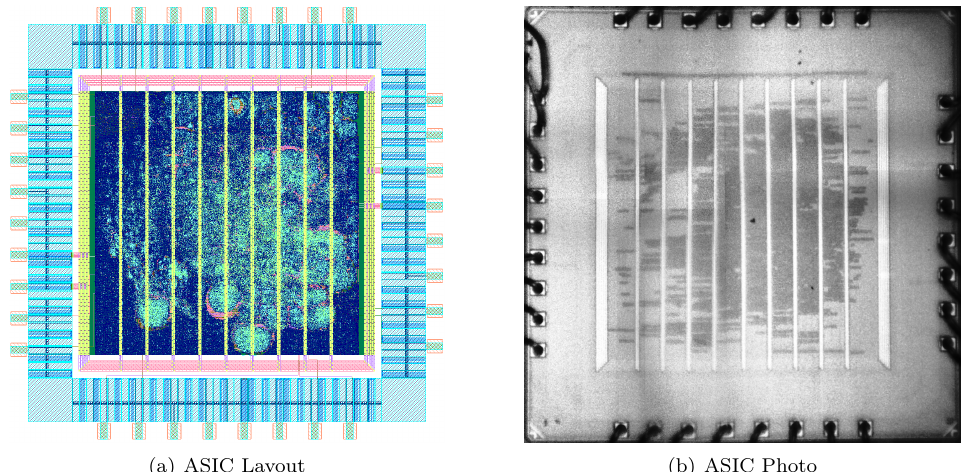
Figure 4: Custom 40 nm ASIC prototype which implements the different SKINNY cores that are targeted in this work.